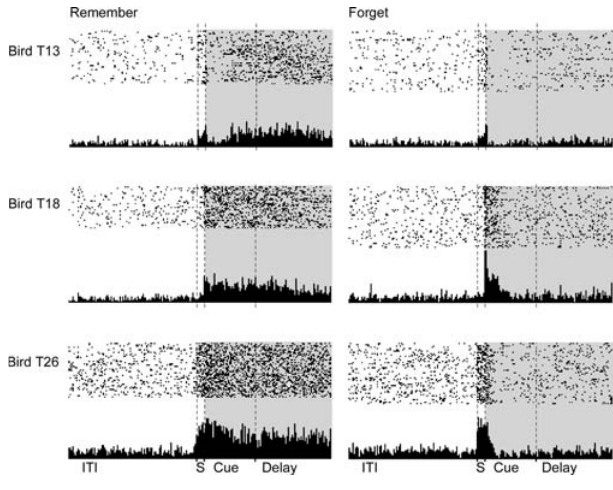
Figure 3. Modulation by Remember and Forget Cues Examples of remember and forget cues modulating neural activity in three delay neurons from three different birds. The cue and delay periods are shaded in grey. On remember trials, there is sustained activation in the cue and delay periods. On forget trials, the sustained activation is abolished. The binwidth is 50 ms. The vertical dashed lines separate the different periods of the task. ITI, intertrial interval; S, sample period. DOI: 10.1371/journal.pbio.0030190.g003 PLoS Biology |